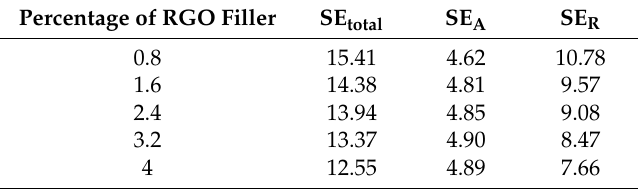
Table 3. The mean EMI SE of RGO/PLA/PEG nanocomposites at different RGO